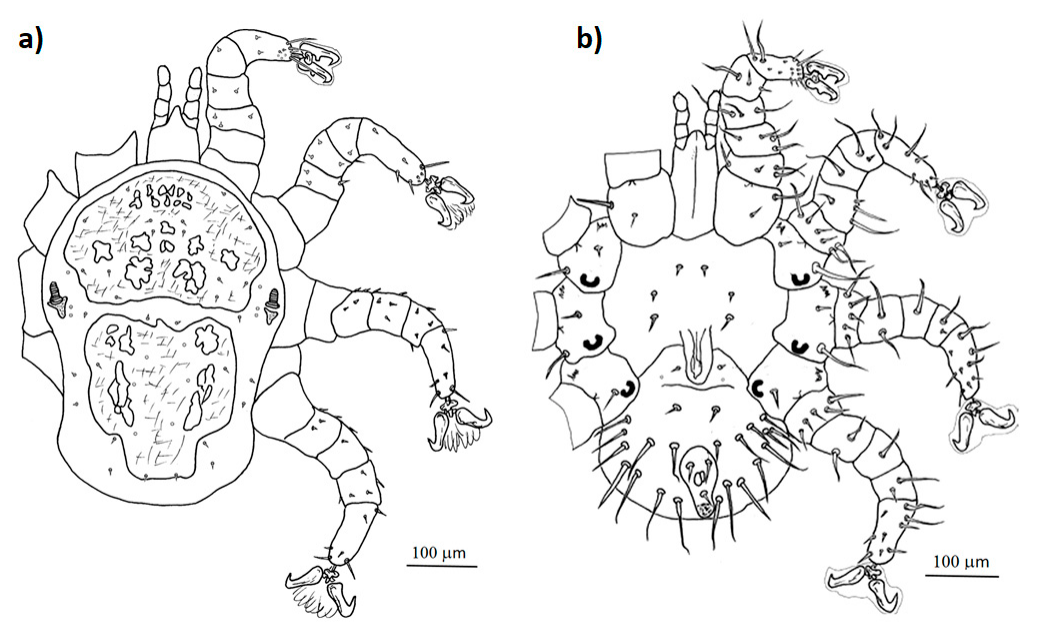
Figure 3. Detailed drawing of the morphological characteristics of female Mesonyssus melloi : ( a ) dorsal view; ( b ) ventral view.